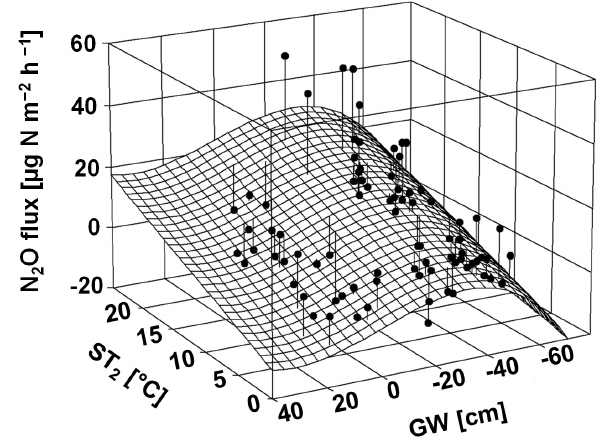
Figure 4. Relationship of net N mineralization in 0–10cm soil depth ( y ) to mean water-filled pore space ( x 1) and mean soil temperature in 5cm soil depth ( x 2) over 21 days of in situ incubation. Equation formula is y = 304.28 ( ± 85.27) · exp( − 0.5 · ((((WFPS − 25.72 ( ± 4.46))/ 11.47 ( ± 1.14)) 2 ) + (((ST 5 − 78.60 ( ± 1.15))/ 11.47 ( ± 1.14)) 2 ))). ( n = 36; adj − R 2 = 0.75; P < 0 . 0001).